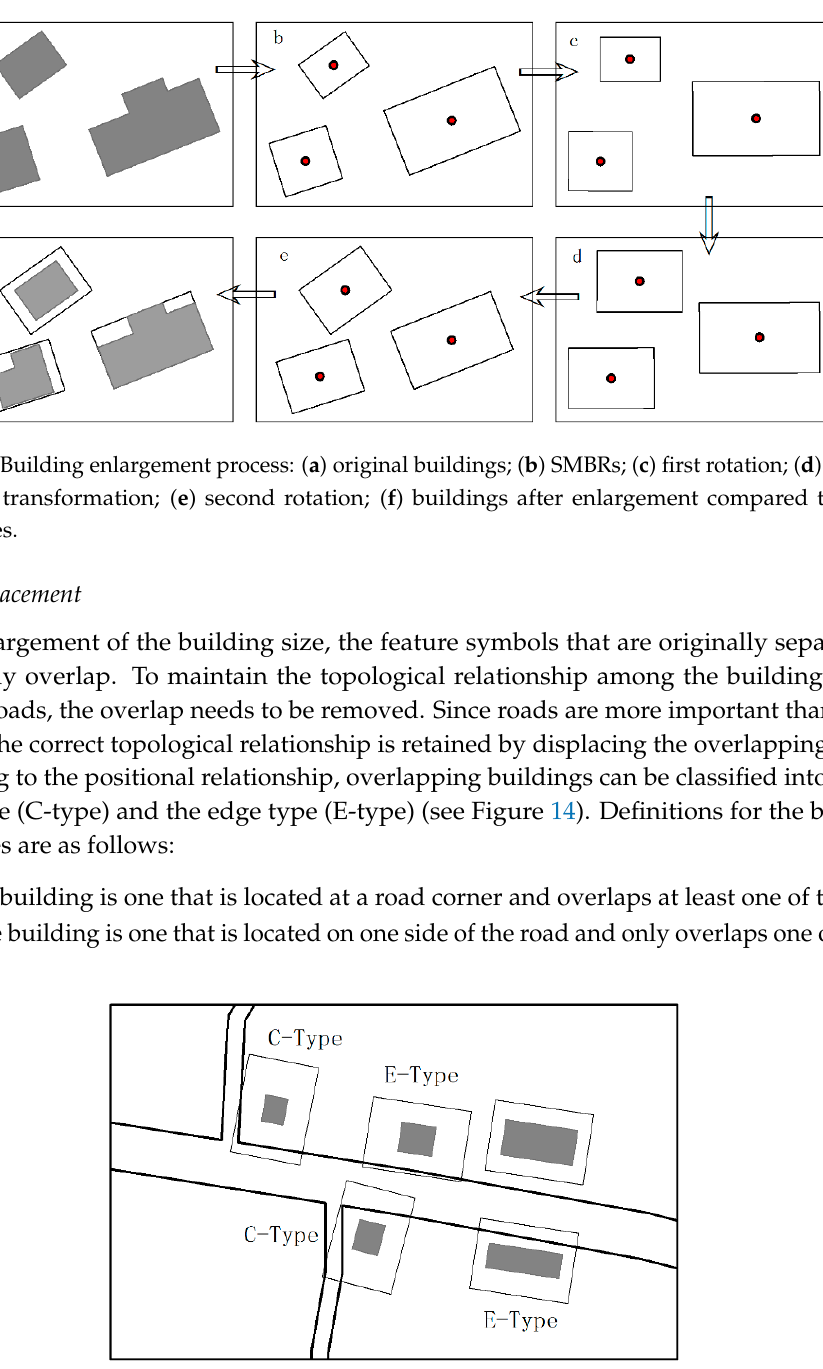
Figure 14. Two types of buildings that overlap surrounding roads.